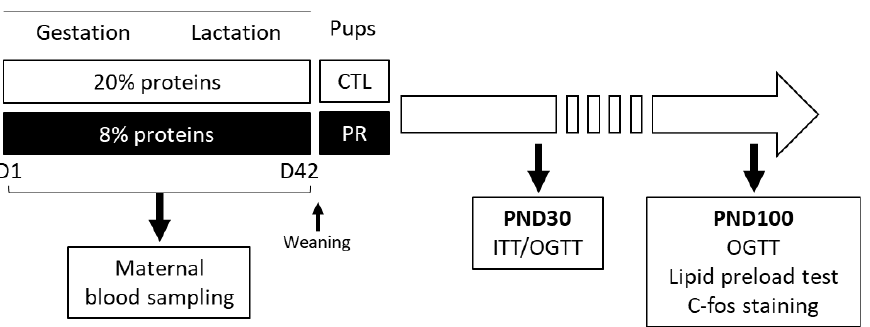
Figure 1. Schematic diagram of the study design. Two groups of animals were generated from mothers fed with control diet (CTL; 20% proteins) or low-protein diet (PR; 8% proteins). Insulin sensitivity and glucose tolerance were studied in offspring at postnatal day (PND) 30 and PND100. Lipid preload test and c-fos staining in brain were performed in female offspring at PND100 to test the impact of maternal diet on hypothalamic lipid sensing in offspring. ITT, insulin tolerance test; OGTT, oral glucose tolerance test. Pregnant dams were weighted three times a week, and food and water intakes were measured at the same times. At birth, litter size was adjusted to 8 pups per dam (4 females and 4 males). Mortality at birth was calculated on 50–56 pups per sex for 13 litters per group in CTL and PR groups. Mothers and pups were weighed three times a week, and food and water intakes were measured at the same times. At weaning, females and males were separated, housed 4 animals per cage, and fed a breeding diet (A03, SAFE, Augy, France) until postnatal day 50 (PND50). Then, rats were housed 3 per cage and fed a standard diet (A04, SAFE, Augy, France) until the end of the experiments, i.e., PND100. At PND21, mothers were anesthetized with isoflurane 4% and decapitated. Liver, mesenteric white adipose tissue (WAT), perirenal WAT, and mammary gland were weighed. Same tissues were also weighed in pregnant dams at G17 [31]. Tissue samples were snap frozen and kept at -80 C until analysis. For each experimental procedure, a maximum of 2 animals per sex from the same litter was